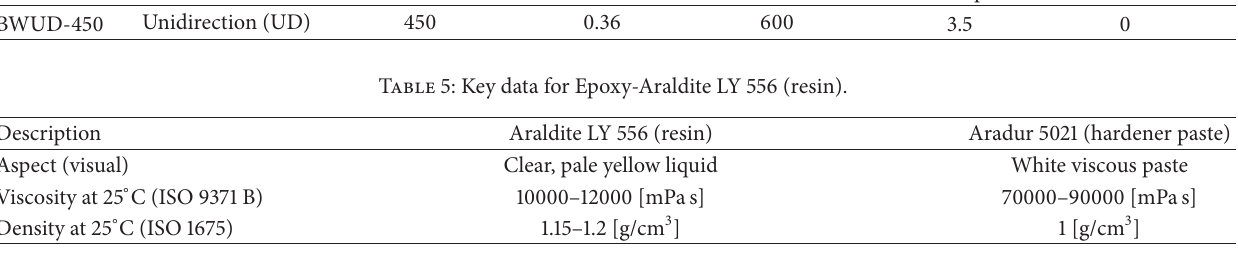
Table 6: Conventional specimen’s